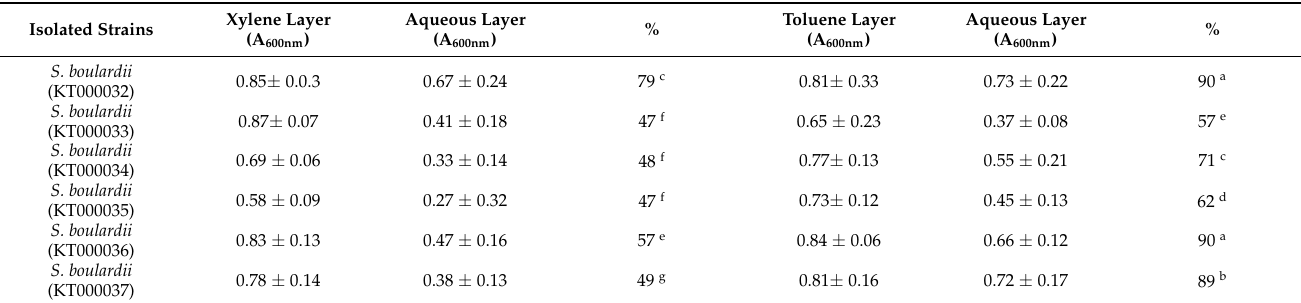
Table 4. Surface hydrophobicity of Saccharomyces boulardii strains with two different solvents (xylene, toluene). Isolated Strains